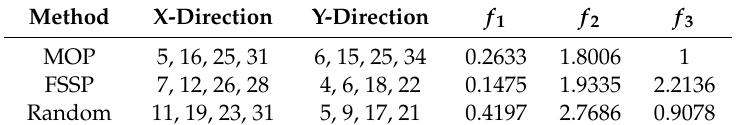
Figure 5. First six modes of the frame structure computed through the FEM.